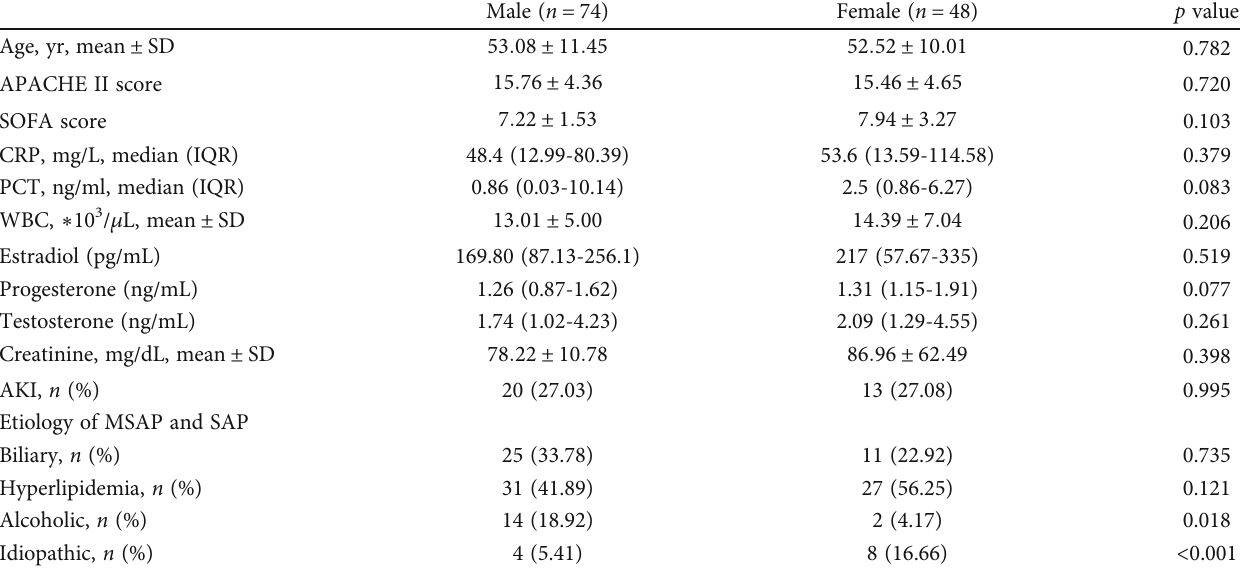
Table 1: Demographics and characteristics of patients classi fi ed by